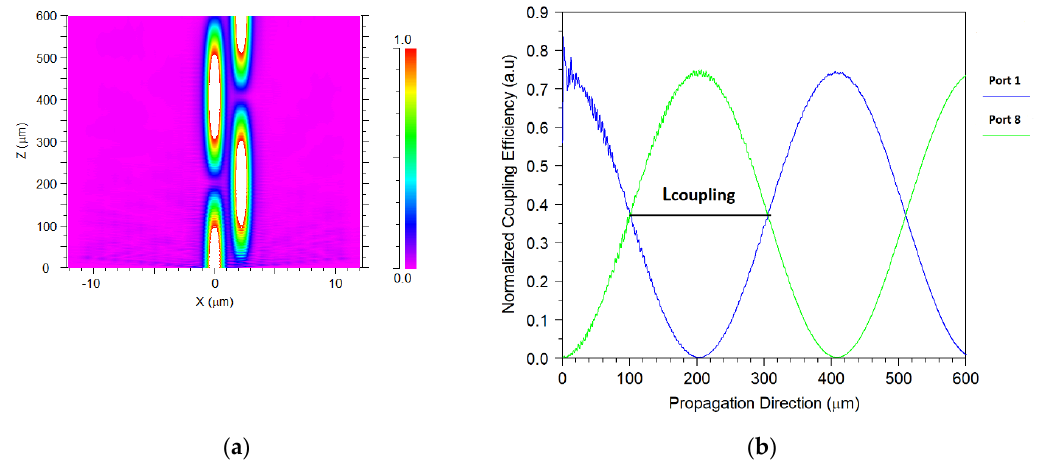
Figure 3. Energy transfer between core 1 and core 8 for the 1565-nm wavelength. ( a ). Intensity profile. ( b ). Normalized coupling efficiency as a function of the propagation direction.